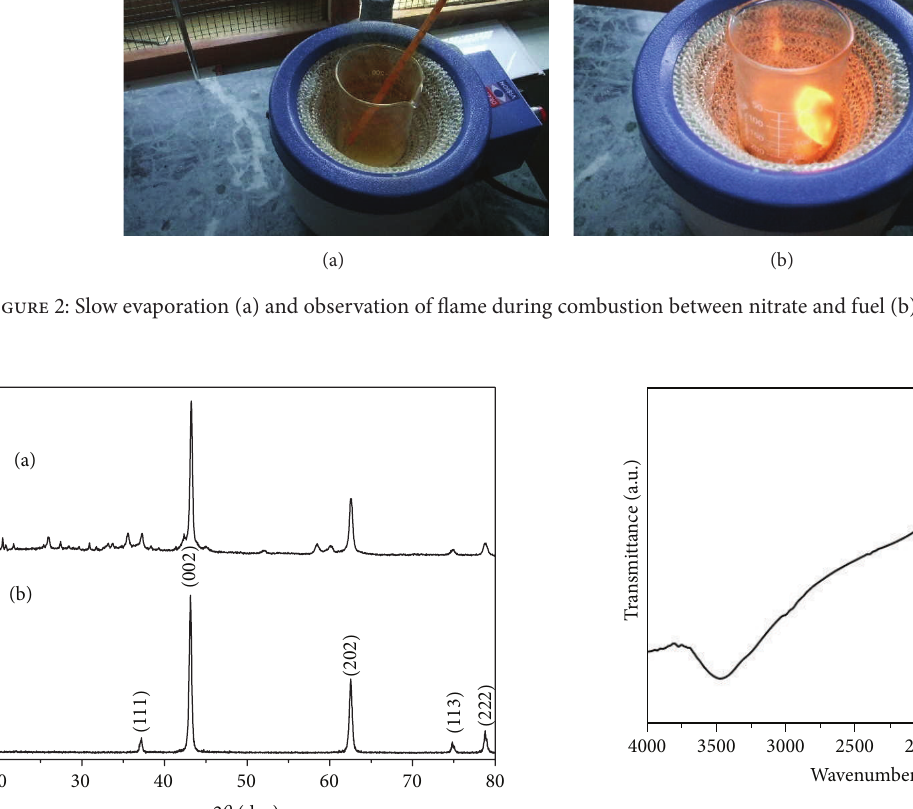
Figure 4: FT-IR spectrum of annealed MgO nanoparticles prepared by combustion followed by annealing